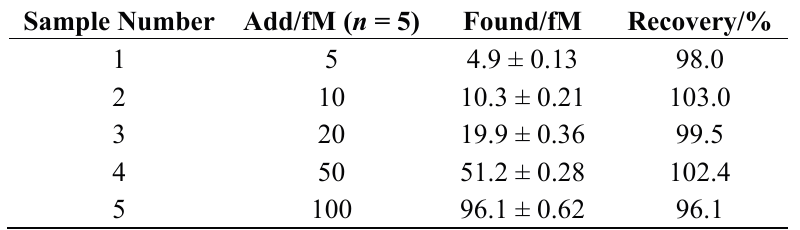
Table 2. The recovery of the proposed ECL genosensor in normal human